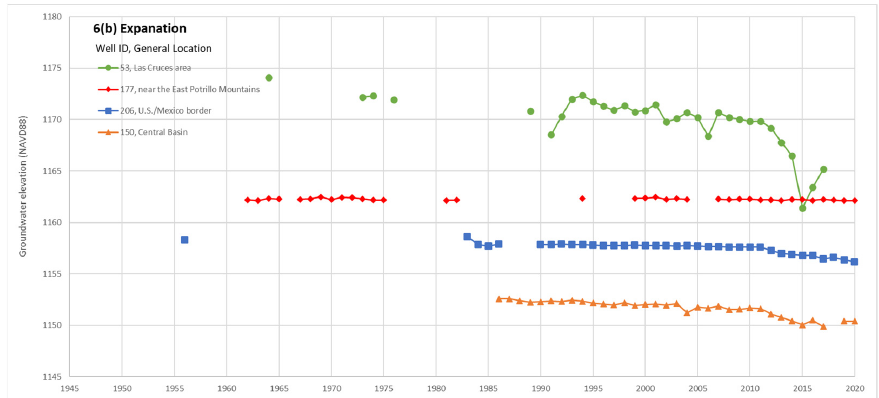
Figure 6. Groundwater levels, 1945–2020. ( a ) Depth to water measured in piezometers screened